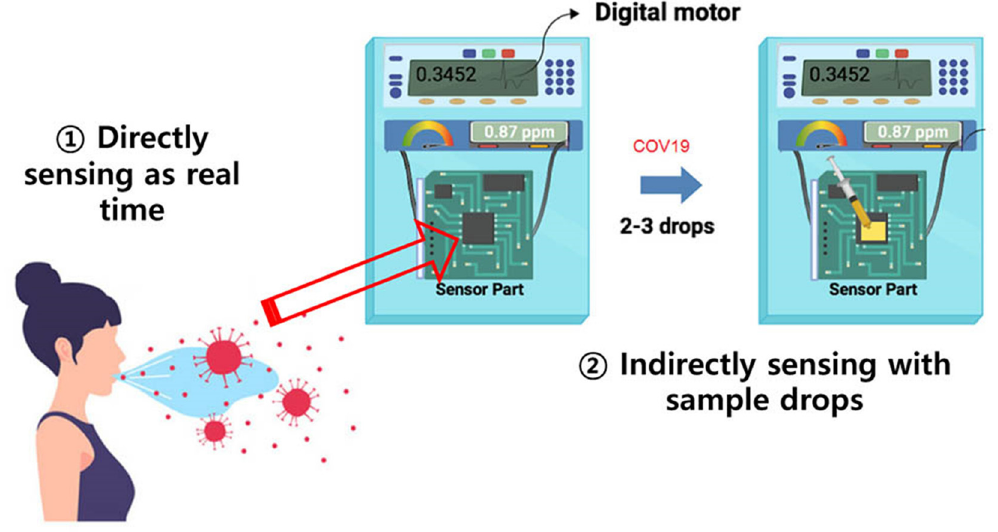
Figure 11: Graphene - based COVID - 19 proposed sensor; the sensor system is working in real - time in droplet transmission conditions or with sample drops obtained from cases [ 88 ]